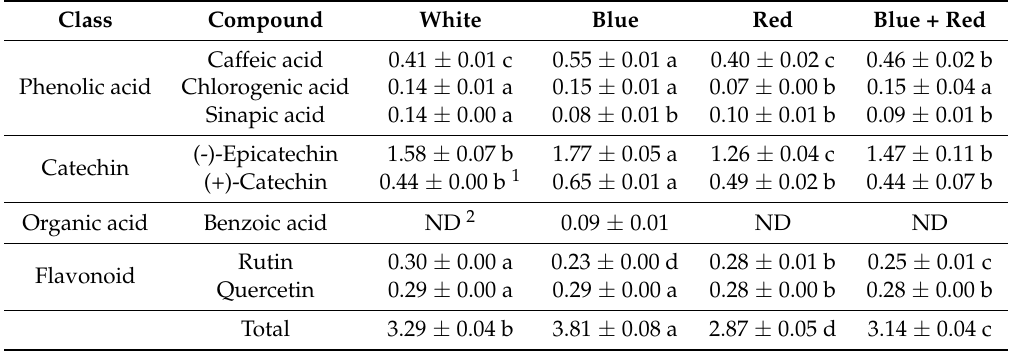
Table 2. The accumulation of phenolics (mg/g dry wt.) in Brassica napus sprouts grown under different LED